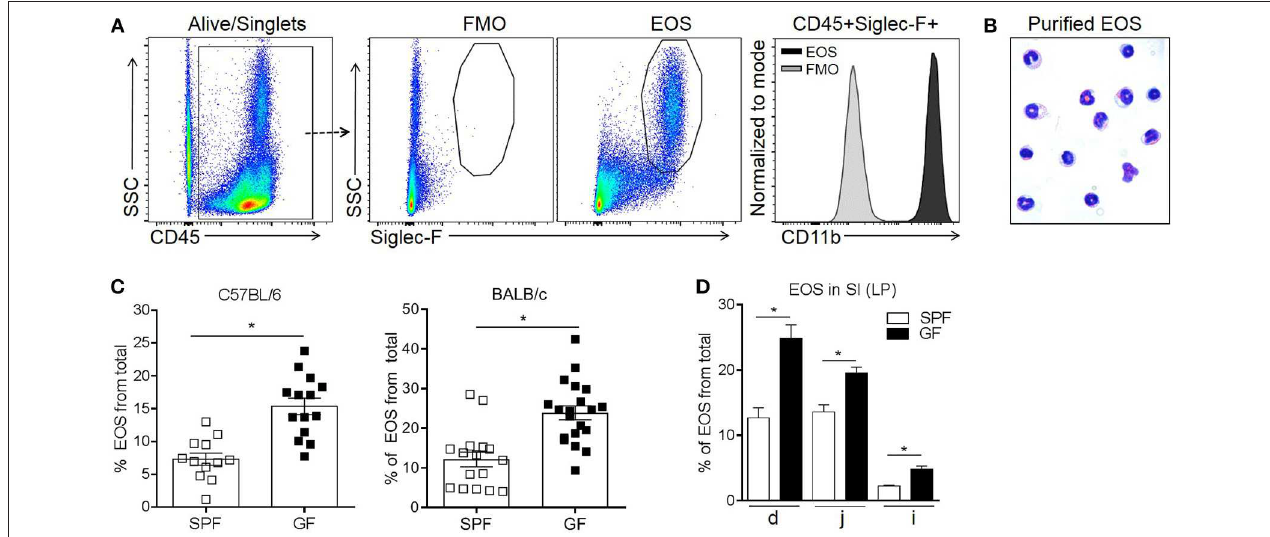
FIGURE 1 | Flow cytometric identification of small intestinal eosinophils (EOS) as live singlet CD45 + Siglec-F + cells (A) , morphologic validation (B) and assessment of their frequency in the small intestine (SI) of SPF and GF C57BL/6 and BALB/c mice (C,D) . The frequency of EOS from total cells in the lamina propria (LP) of different sections of the SI including duodenum (d), jejunum (j) and ileum (i) of C57BL/6 mice (D) . Pooled data from 3 to 4 experiments ( n = 12–20) (C) or representative data from 3 experiments (D) represented as mean ± SEM, * P < 0.05.